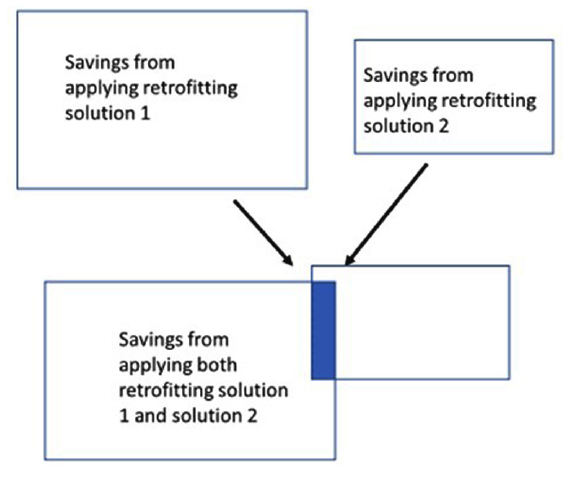
Fig. 1. Background of utilizability